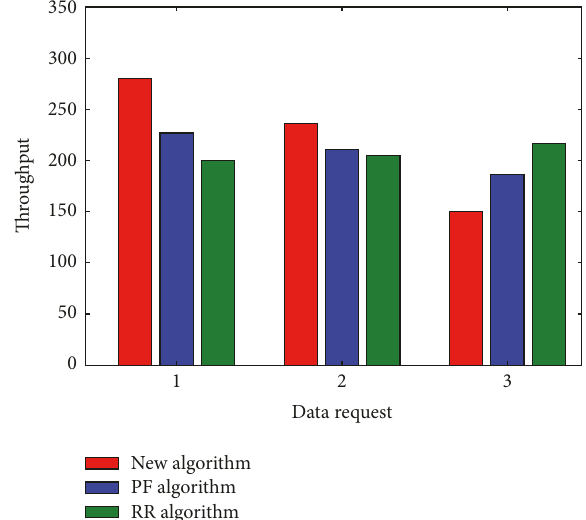
Figure 5: System fairness under different algorithm.